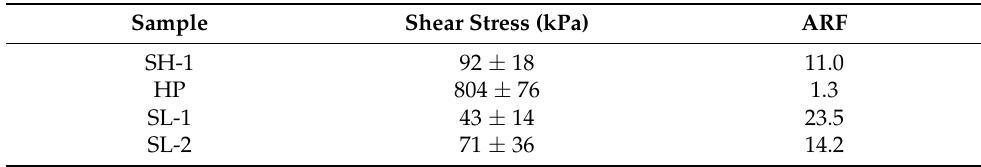
Table 3. Shear stress values and ARF of the tested samples. The shear stress of bare aluminium alloy is 1009 ± 230